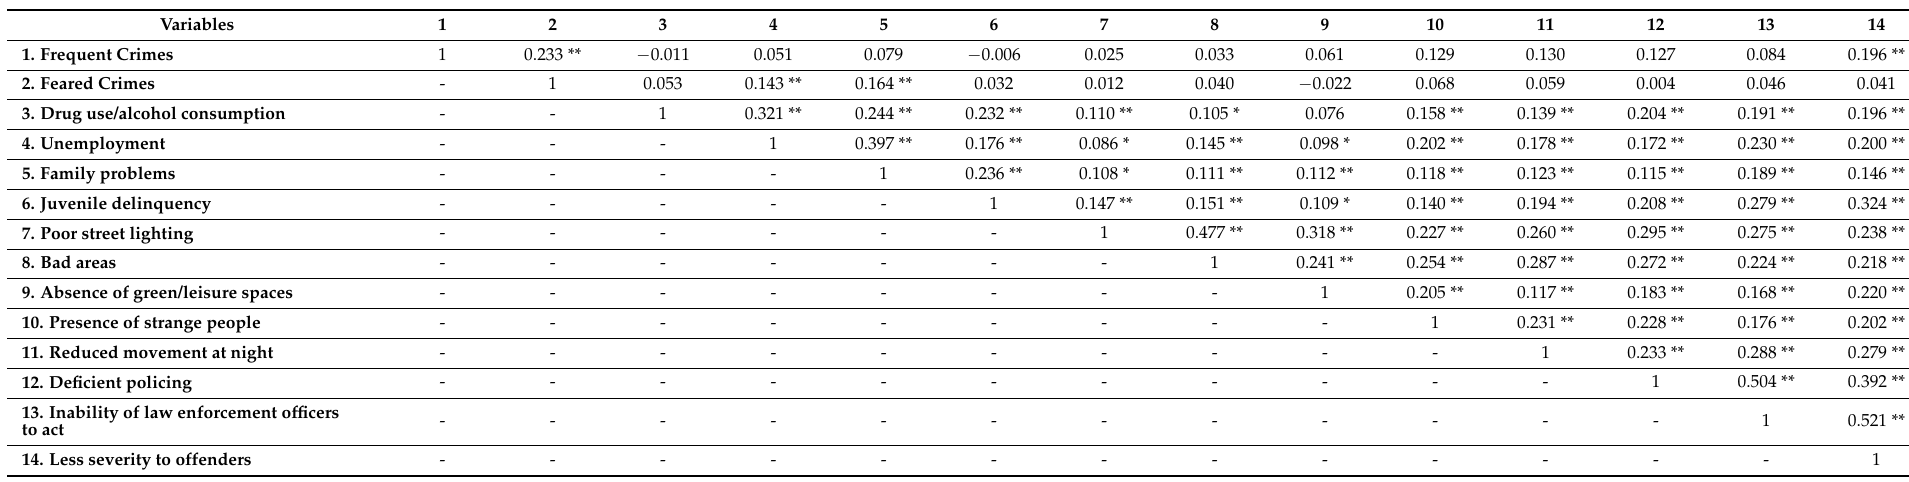
Table 2. Spearman correlations between frequent and feared crimes, and the social/environmental variables of the studied territory. Variables